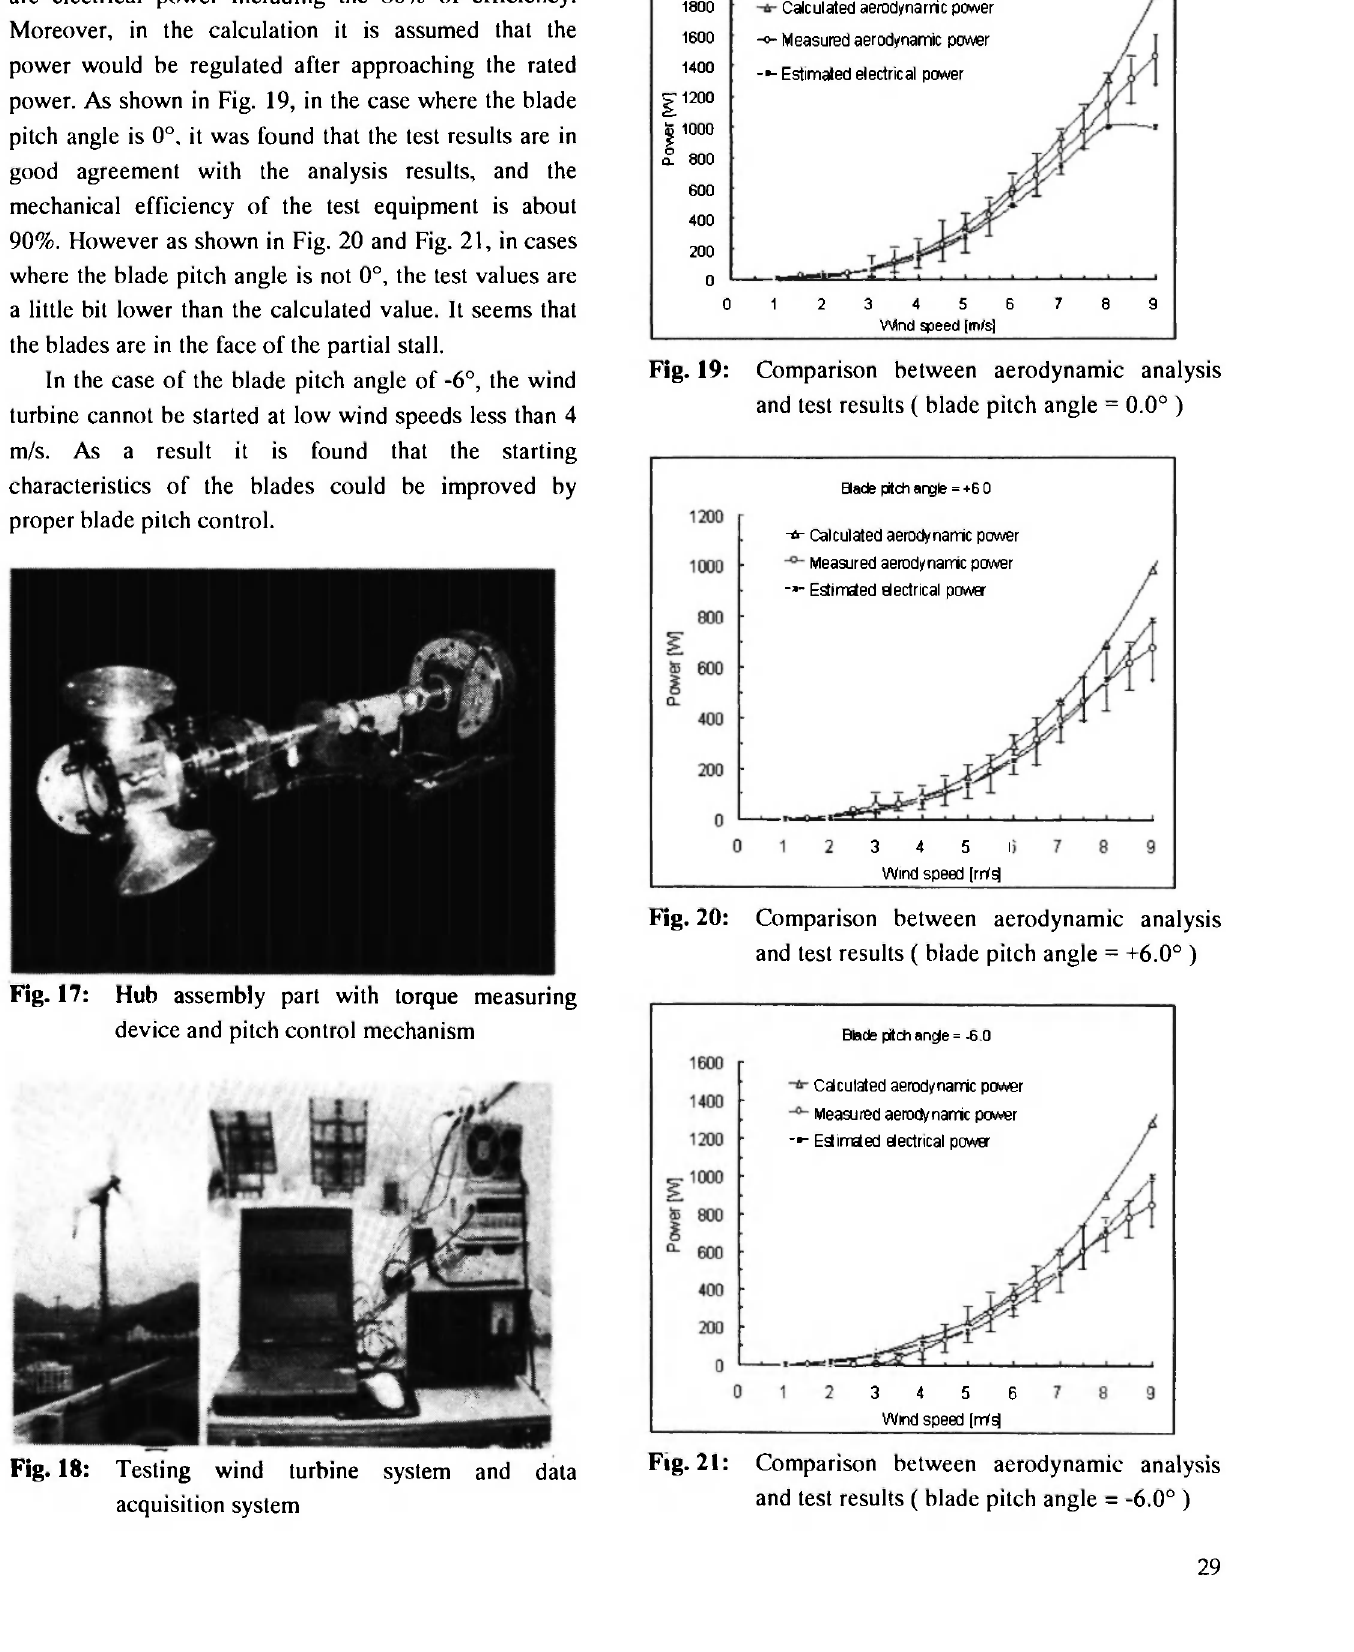
Fig. 18: Testing wind turbine system and data F«g- 21: Comparison between aerodynamic analysis acquisition